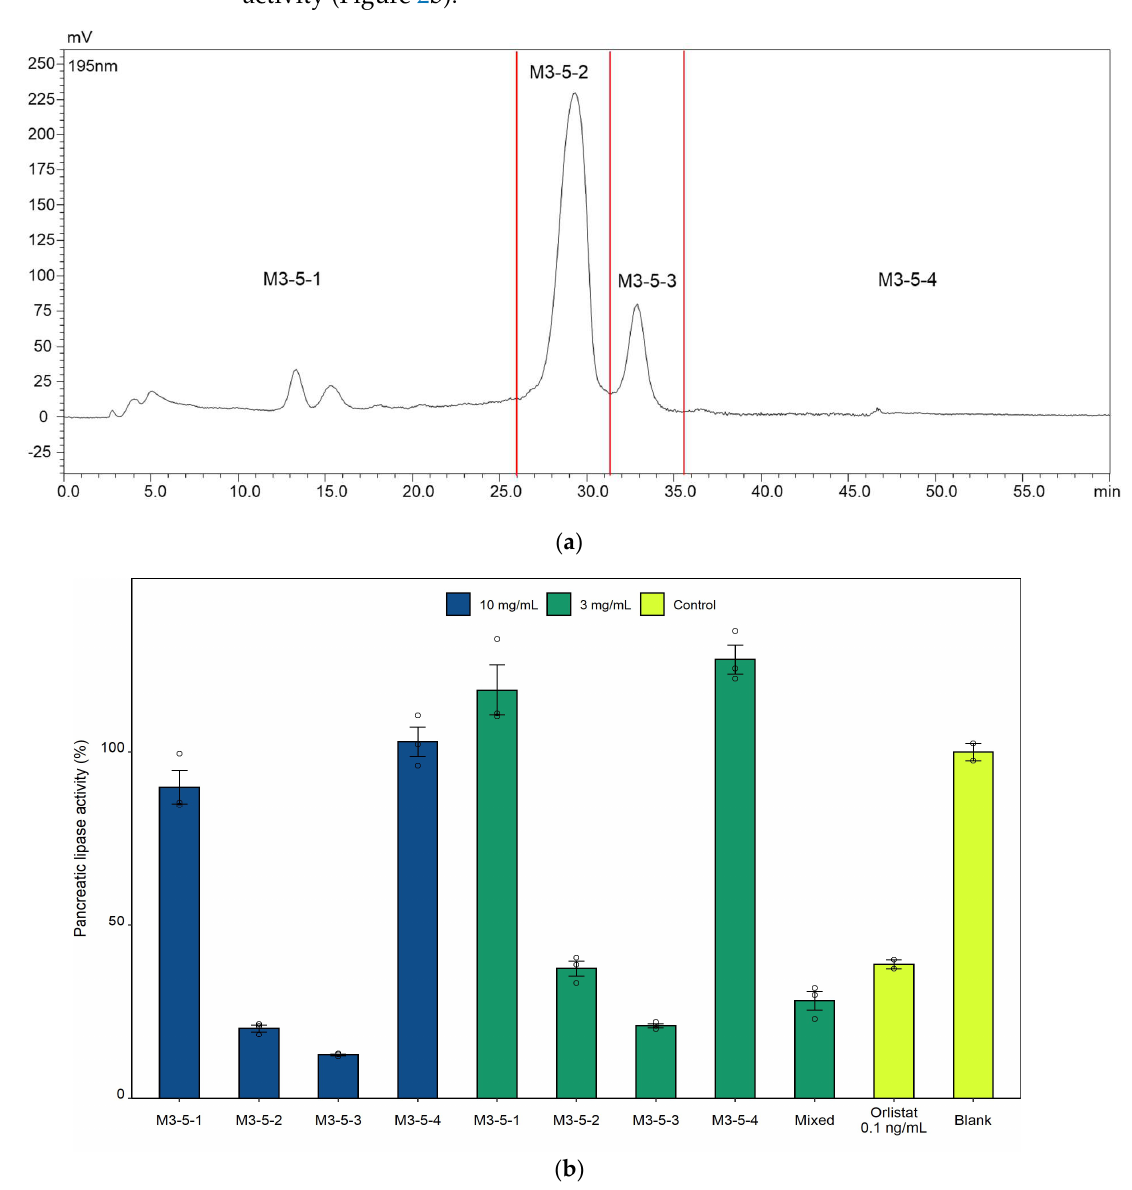
Figure 2. In vitro pancreatic lipase activity of the fractions derived from sesame meal. ( a ) Frac- tionation of the 100% methanolic fraction with HPLC on a polymeric ODS column afforded four fractions (M3-5-1, 2, 3, and 4). ( b ) Two (M3-5-2 and M3-5-3) of the four fractions in ( a ) displayed high potency against pancreatic lipase. The concentrations of fraction M3-5-1, 2, 3, and 4 were equivalent to 10 mg/mL (blue bar) and 3 mg/mL (green bar) of the 50% ethanol